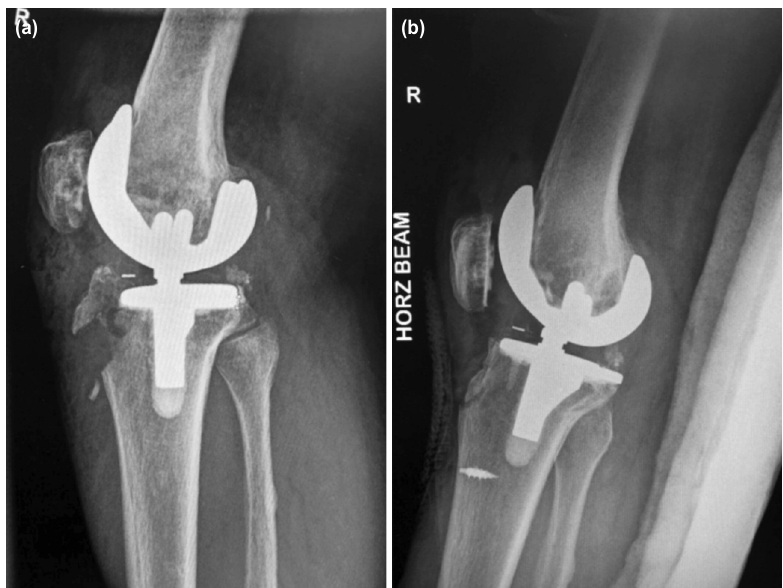
(a) Pre-operative, (b) post-operative radiograph lateral view of right knee (metallic anchor suture used here). Fig. 3: